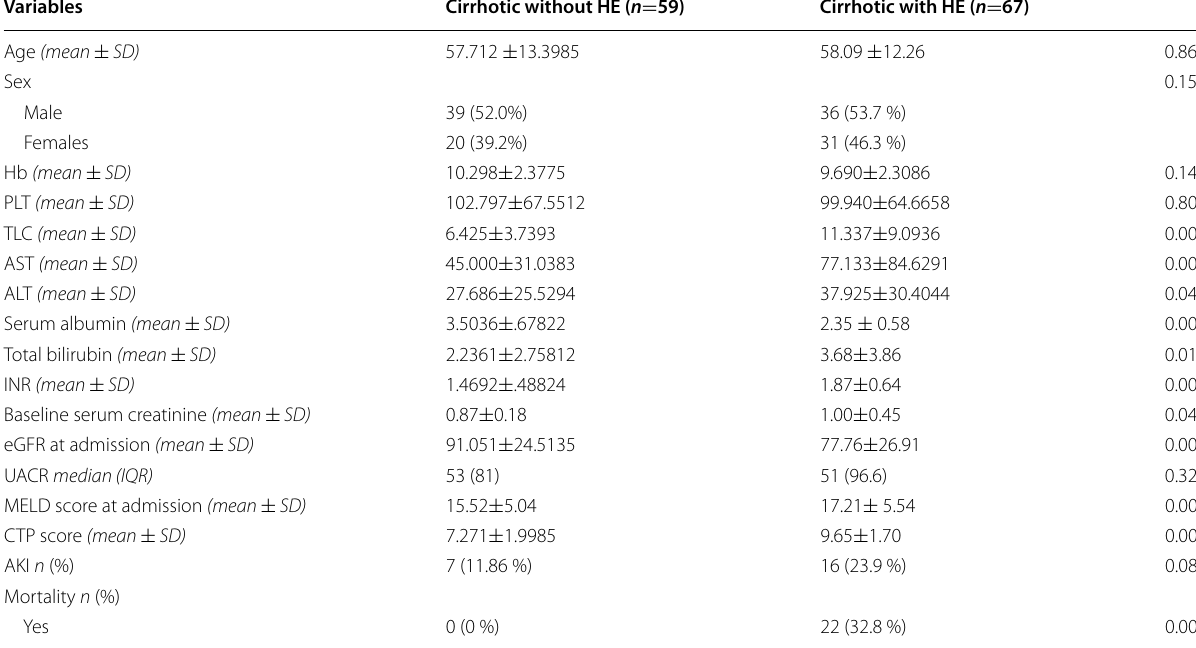
Table 2 Baseline characteristics of patients with no‑HE versus those with HE